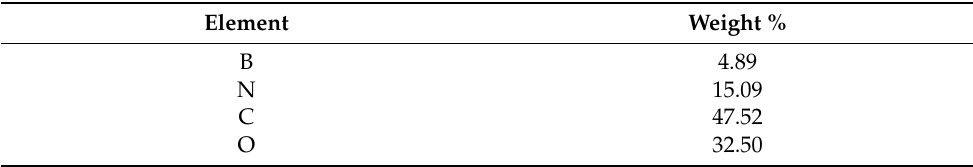
Table 10. Different species present in 0.6 wt % of GNP and h-BN in epoxy.